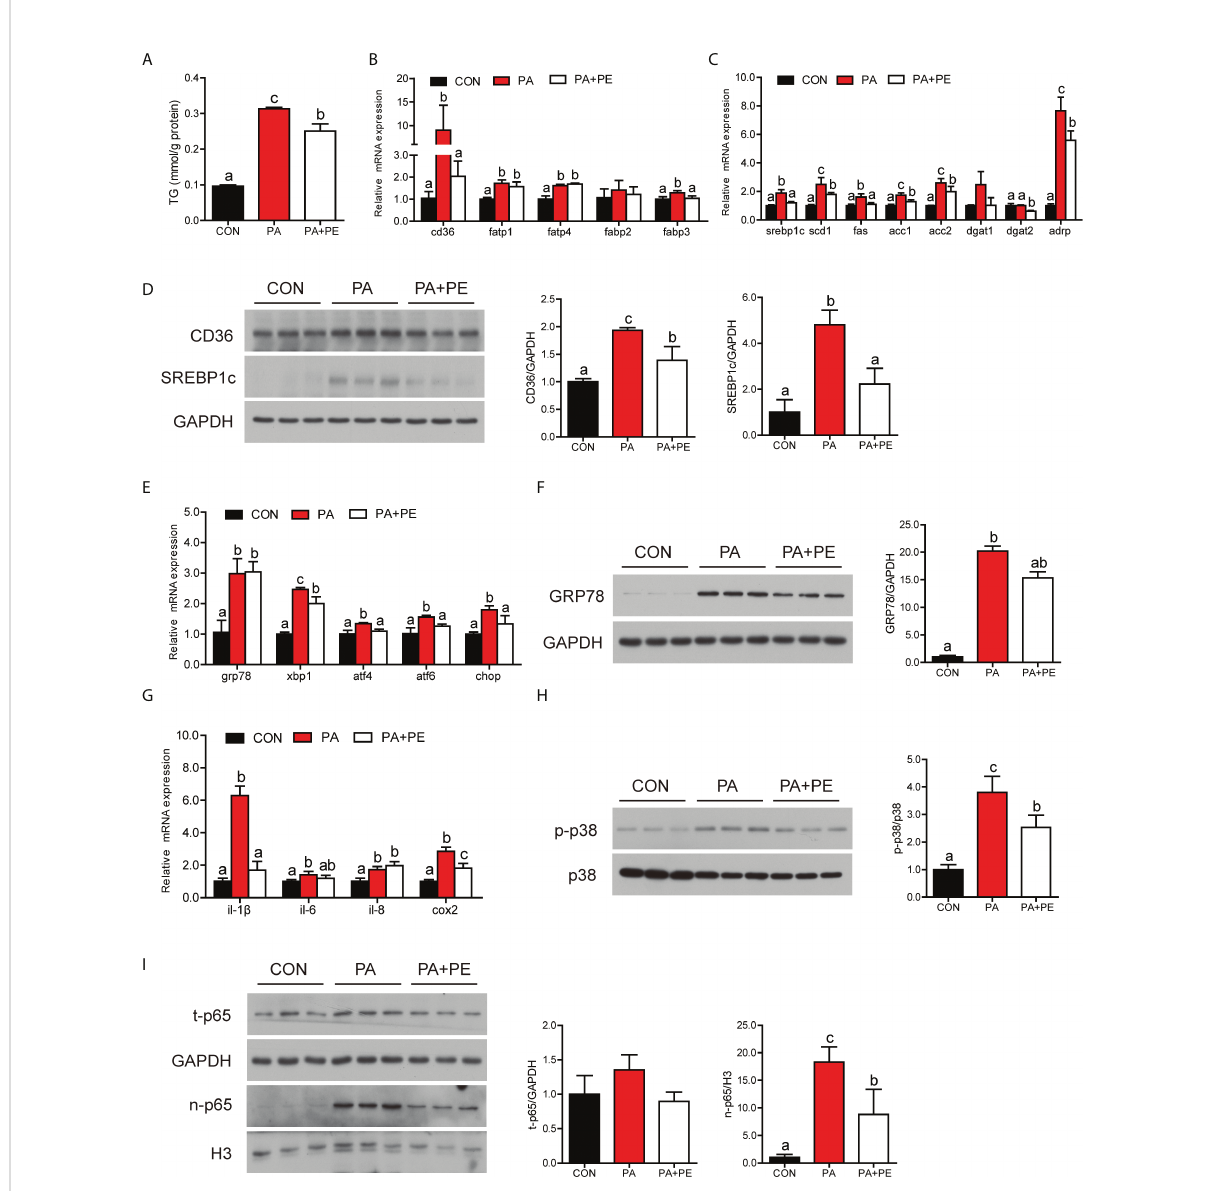
FIGURE 5 The addition of PE alleviated the damage of intestine cells caused by PA treatment to some extent. (A) TG content in the intestinal cells after different treatments (n = 3). (B) Fatty acid uptake and (C) lipid synthesis-related genes expression in the intestinal cells after different treatments (n = 3). (D) Protein levels of CD36 and cleavage of SREBP1c in the intestinal cells after different treatments (n = 3). (E) Relative mRNA expression of ER stress-related genes in the intestinal cells after different treatments (n = 3). (F) Protein level of GRP78 in the intestinal cells after different treatments (n = 3). (G) Relative mRNA expression of proin fl ammatory genes in the intestinal cells after different treatments (n = 3). (H) Protein levels of p-p38 MAPK and p38 MAPK in the intestinal cells after different treatments (n = 3). (I) Protein levels of total p65 and nuclear p65 in the intestinal cells after different treatments (n = 3). Results were presented as mean ± standard deviation (SD) and analyzed using one-way analysis of variance (ANOVA) followed by Tukey ’ s test (values without the same letter indicate signi fi cant difference among three treatments P < 0.05). CON, bovine serum albumin treatment; PA, palmitic acid treatment; PA+PE, palmitic acid and phosphatidylethanolamine